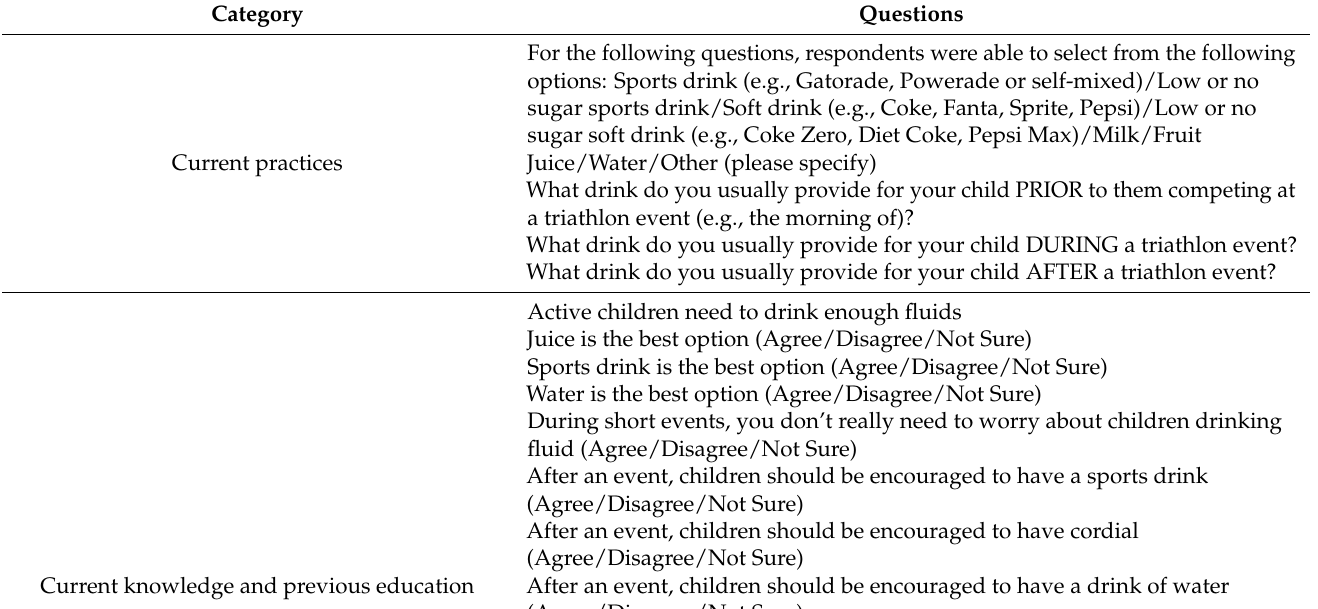
Table 2. Questionnaire administered to parents at the Triathlon Victoria event held in